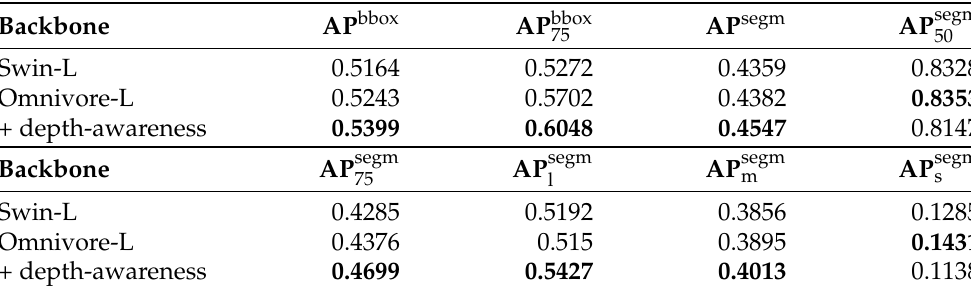
Table 2. COCO metrics on the Plittersdorf instance segmentation dataset task using Cascade Mask R-CNN with different backbones and 10-fold cross-validation. The respective best value for each metric is highlighted in